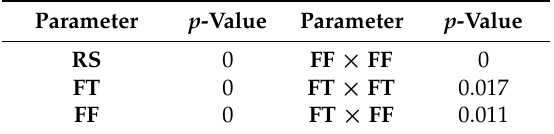
Table 7. Statistical significance (p-values) of reduced model factors. Table 7 . Statistical significance (p-values) of reduced model factors. Table 7 . Statistical significance (p-values) of reduced model factors.